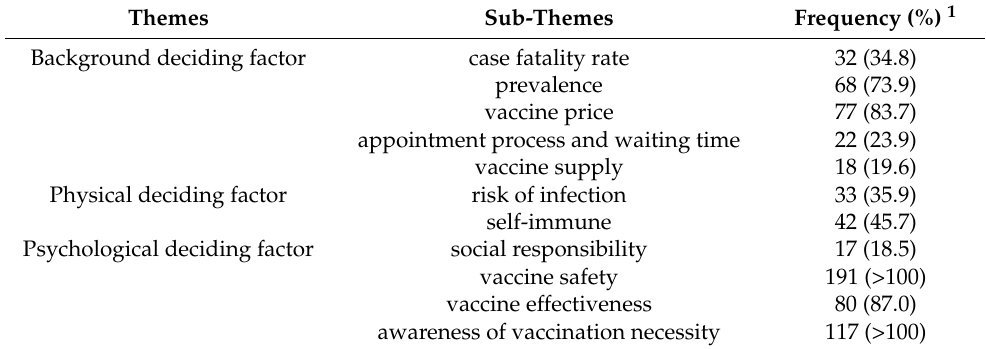
Table 3. The most frequently mentioned factors influencing vaccine hesitancy in Chinese